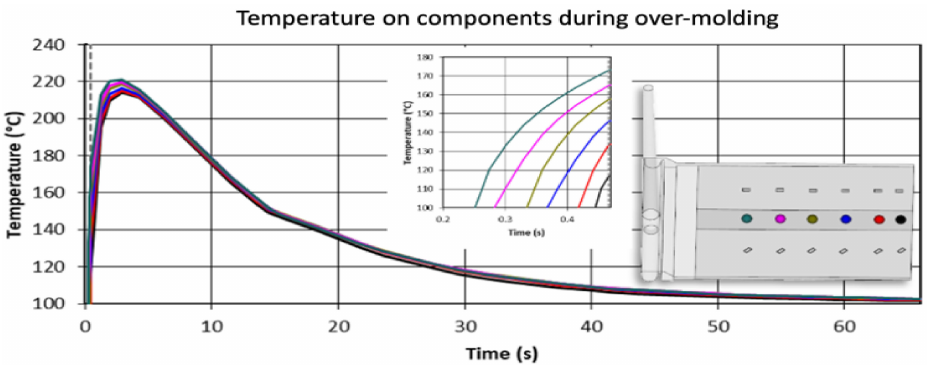
Figure 7. The temperature profile of the components during over-molding with